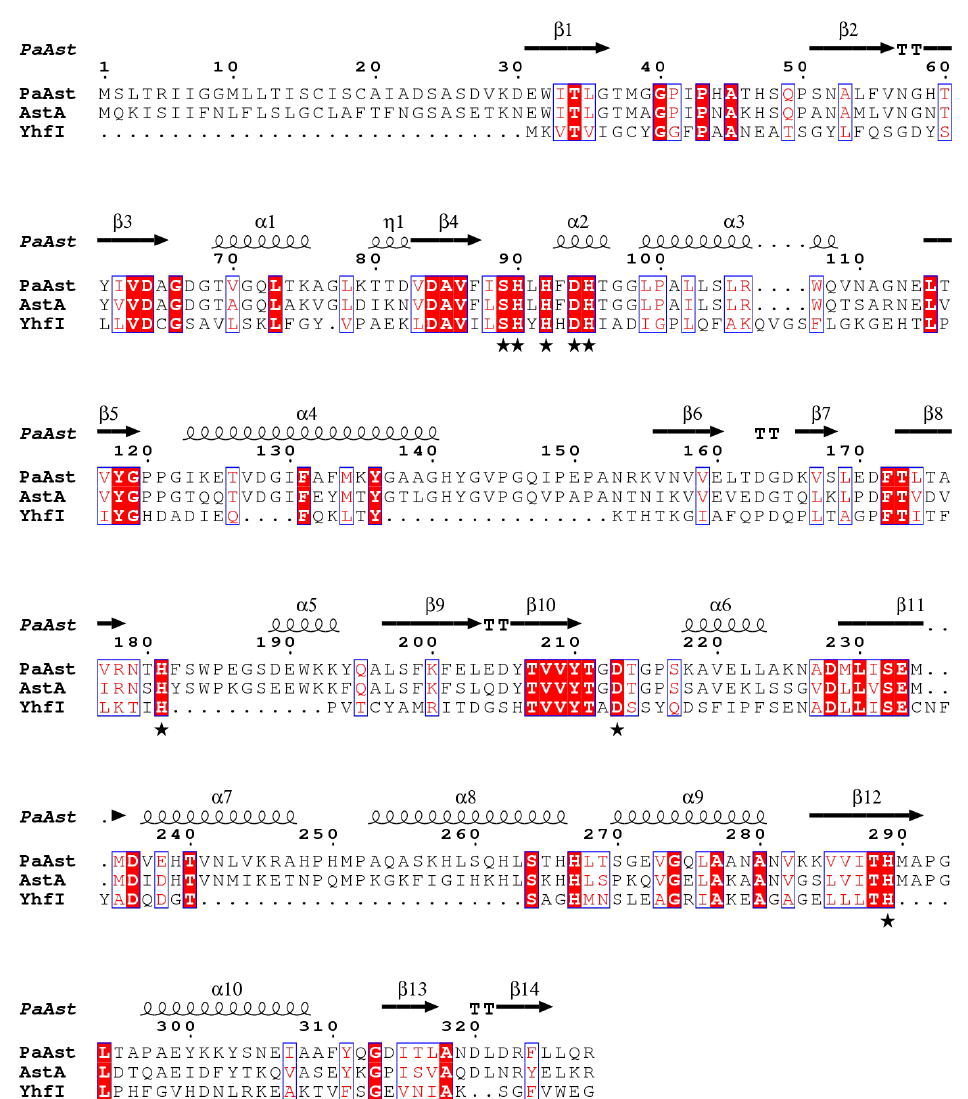
Figure 1. Sequence alignment of PaAst (GenBank: ABG39403.1), AtsA (GenBank: CAA46628.1), and YhfI (GenBank: ADM37089.1). Identical residues are highlighted in red, similar residues are framed in blue, and residues in the conserved Zn 2+ -binding motifs are labeled with stars.